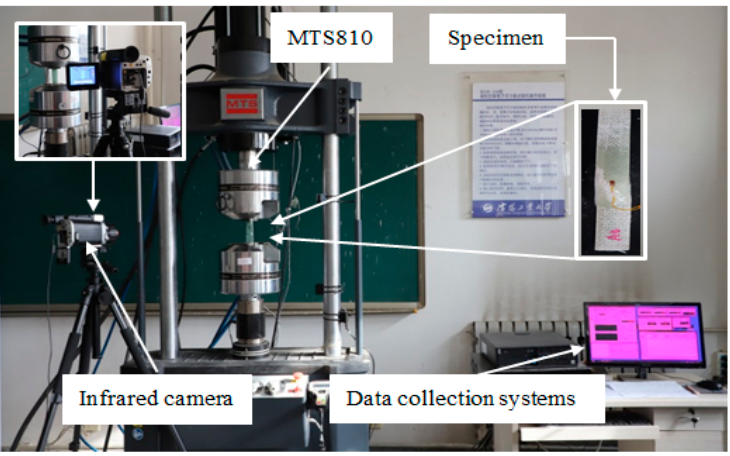
Figure 3. Fatigue infrared thermal imaging test.